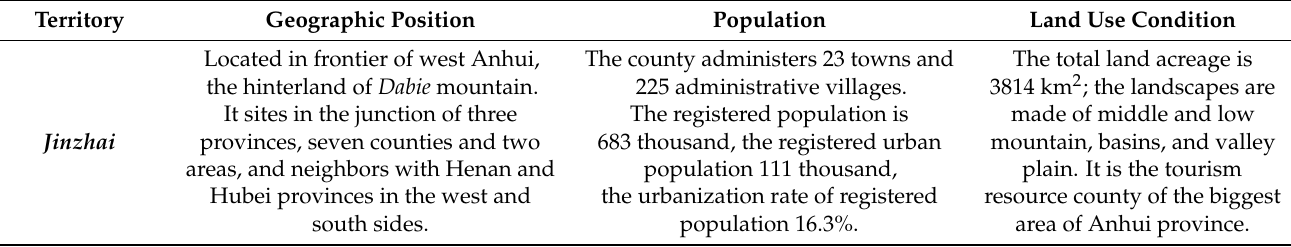
Table A2. Basic information on the research areas of Jinzhai .